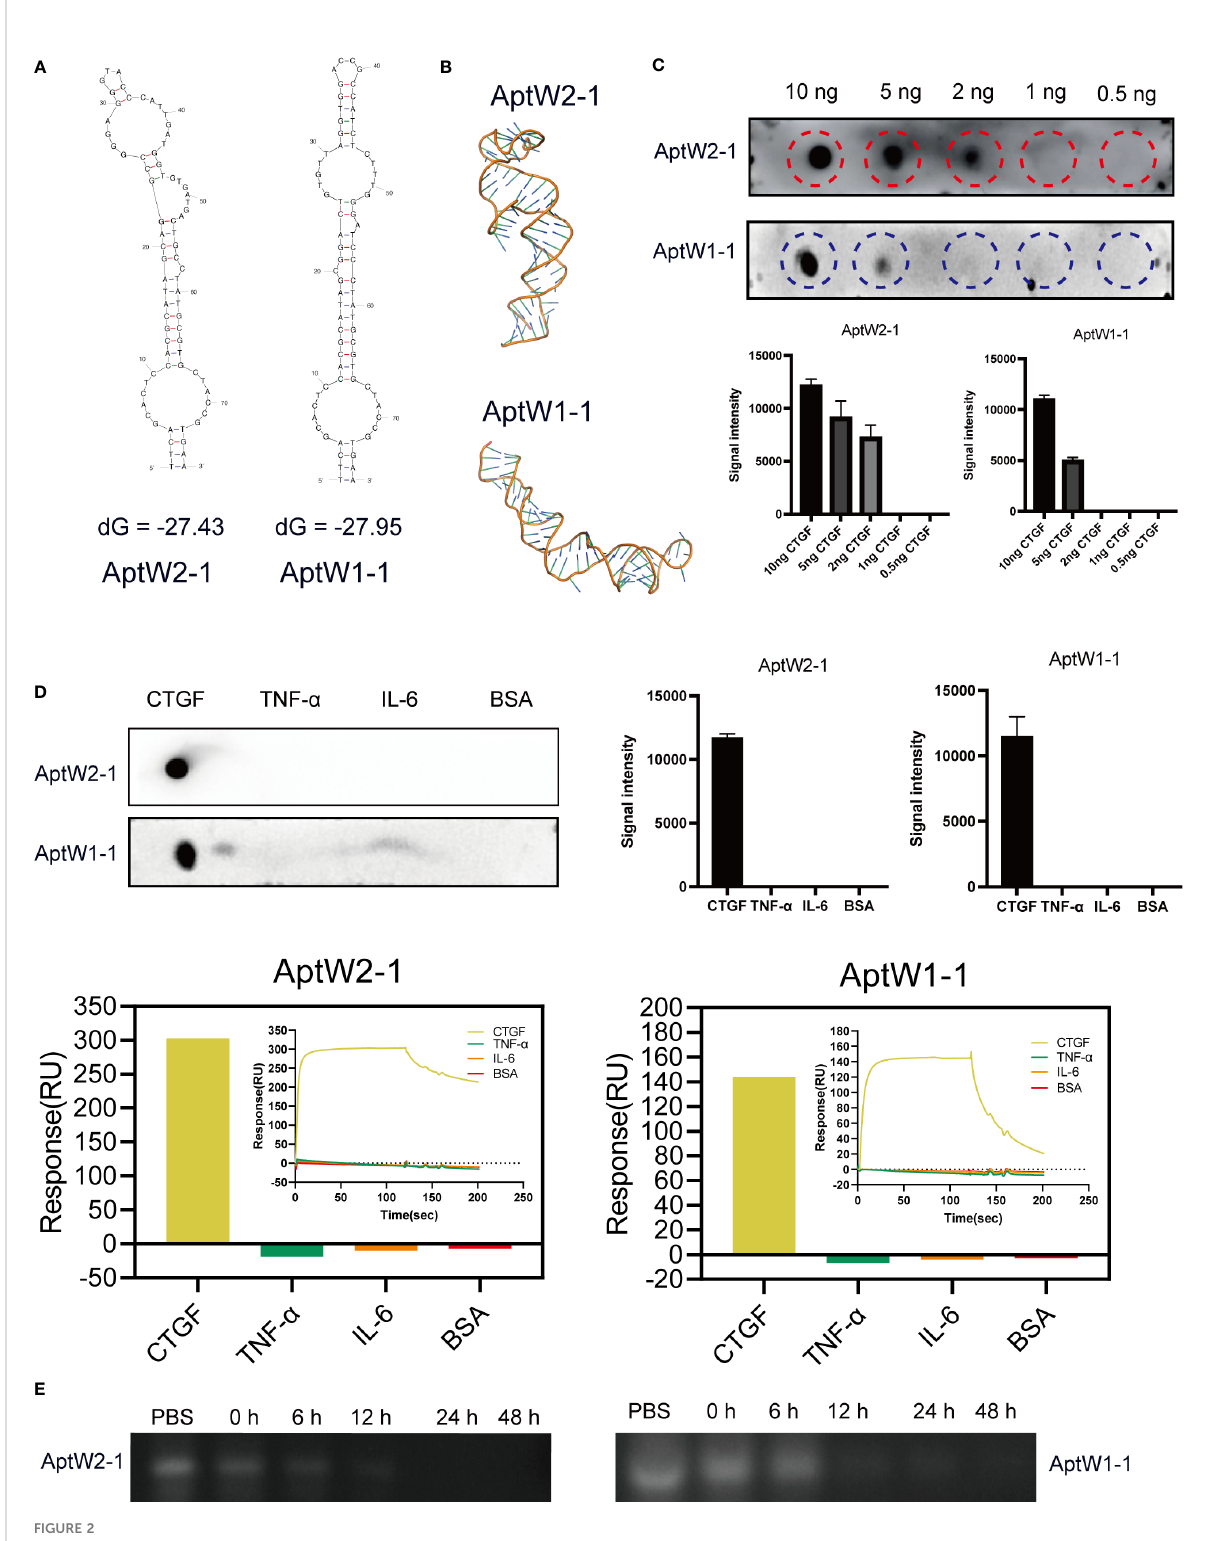
FIGURE 2 Bioinformatic structural analysis and properties of assays of the aptamers obtained. (A) Secondary structural prediction of AptW2-1 and AptW1- 1. (B) Tertiary structures of the analog images of AptW2-1 and AptW1-1. (C) Sensitivity assays of AptW2-1 and AptW1-1 targeting CTGF at gradient concentrations. (D) Speci fi city assays (upper) and SPR assays (lower) of AptW2-1 and AptW1-1 were tested with other RA-related cytokines, including TNF- a and IL-6. (E) Stability assays of AptW2-1 and AptW1-1 were incubated with plasma from healthy